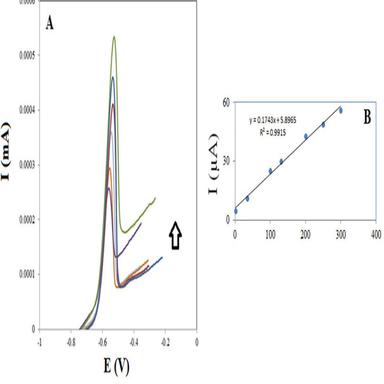
(A) DPASV response on the GO-imi- (CH2)2-NH2 /CPE with different concentrations of Pb(II) in acetate buffer (pH 5.0); (B) the corresponding linear calibration plots of peak currents for Pb(II).